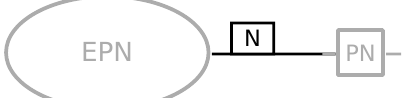
Figure 2.38: The Process Description glyph for consumption